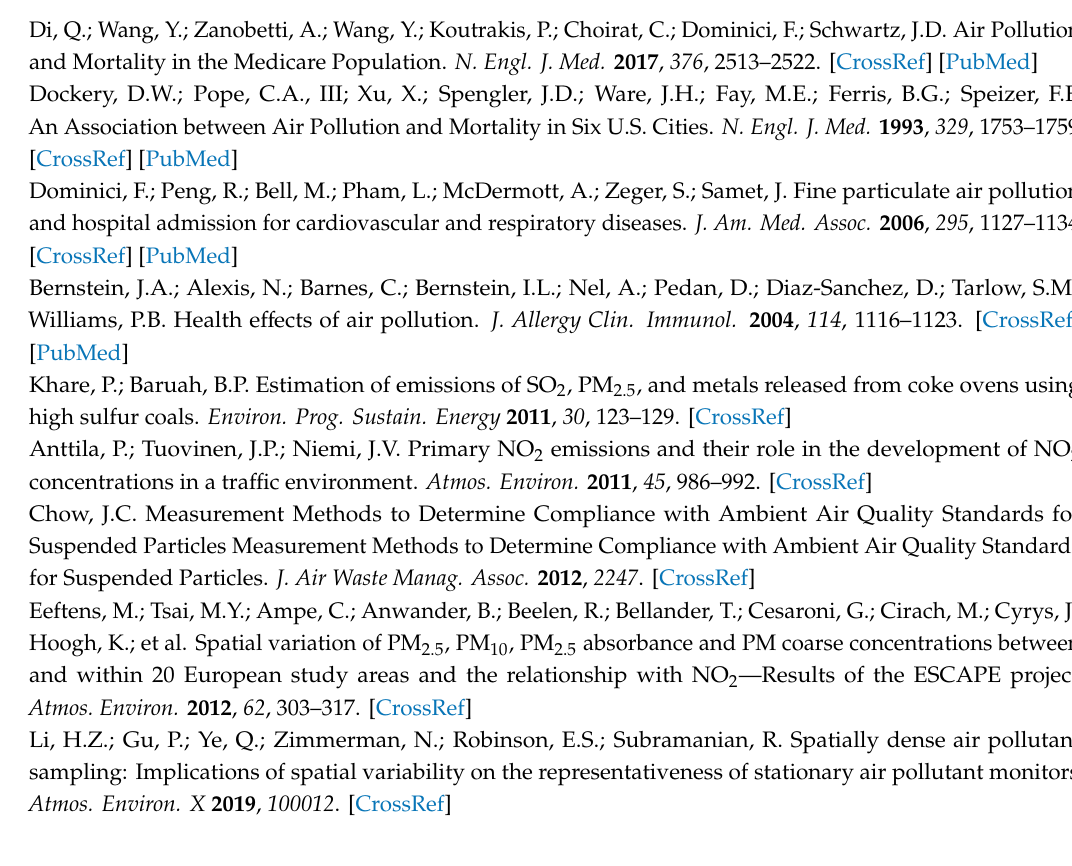
Table S1: RAMP Locations, Figure S1: Seasonal Data Coverage, Figure S2: Seasonal Concentrations of PM 2.5 , Figure S3: Variability Among Co-Located RAMPs, Figure S4: Relationships between Excess PM 2.5 and SO 2 , Figure S5: Variability of SO 2 . Figure S6: Wind